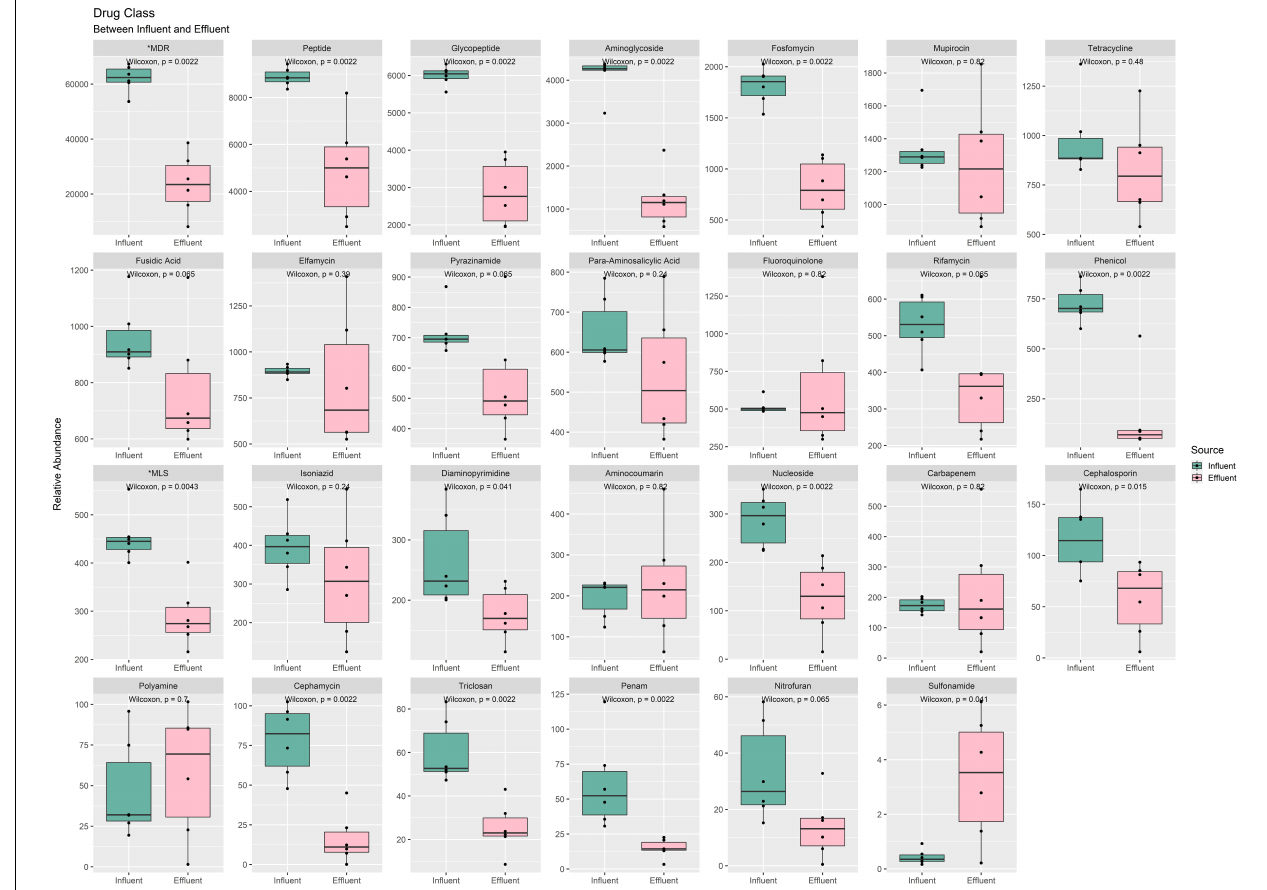
FIGURE 8 | Box plots of the ARG drug class phenotype, grouped between influent and effluent. *MDR, multidrug resistance; *MLS,